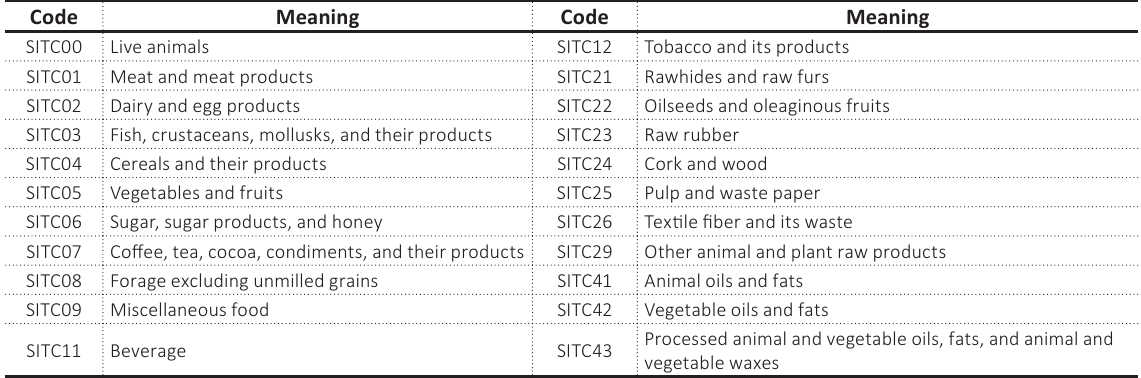
Table 1. SITC classification of agricultural